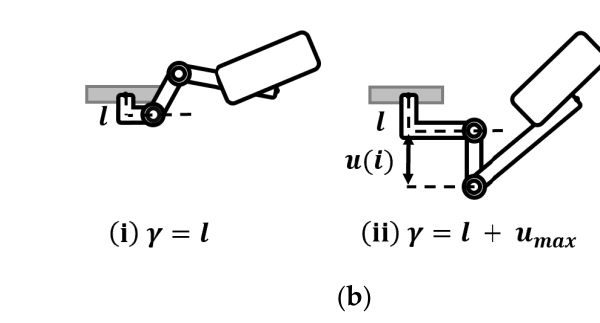
Figure 8. Parameters for each objective function of optimization: ( a ) Translated point 𝑃 𝑜𝑓𝑓𝑠𝑒𝑡 and end point of the joint configuration 𝑃 𝑒𝑛𝑑 . ( b ) Definition of each 𝛾 , which indicates the protrusion dimension of the configuration.